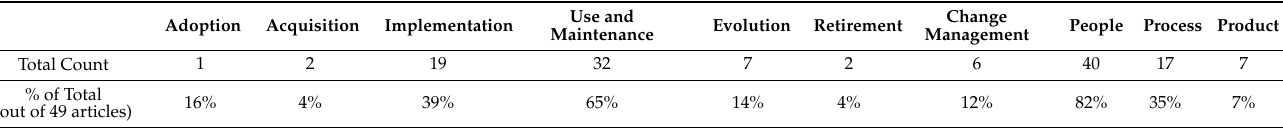
Table 5. The total count and percentages of total included articles for every phase and dimension within the ESs implemen- tation lifecycle. Adoption